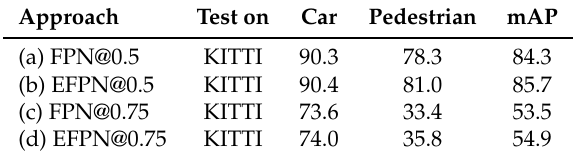
Table 3. Object detection results evaluated on KITTI.